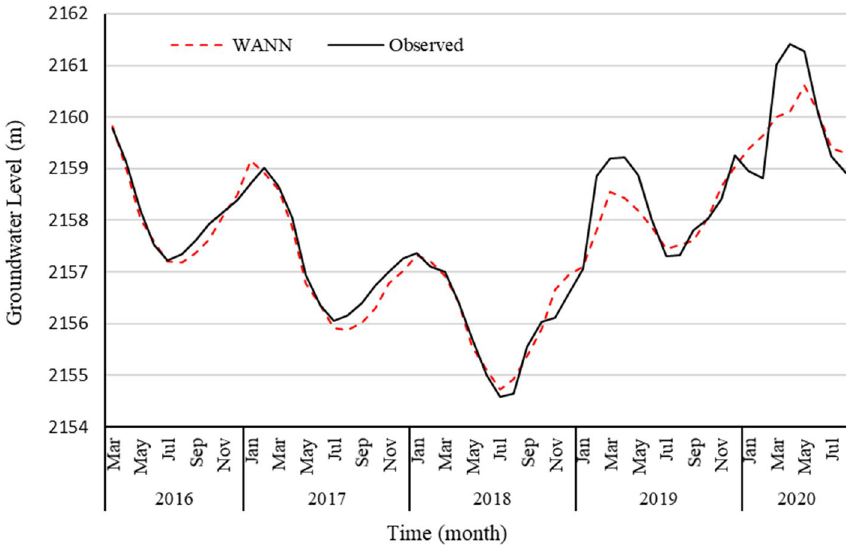
Fig. 9 Comparison of the W-ANN model with observed data